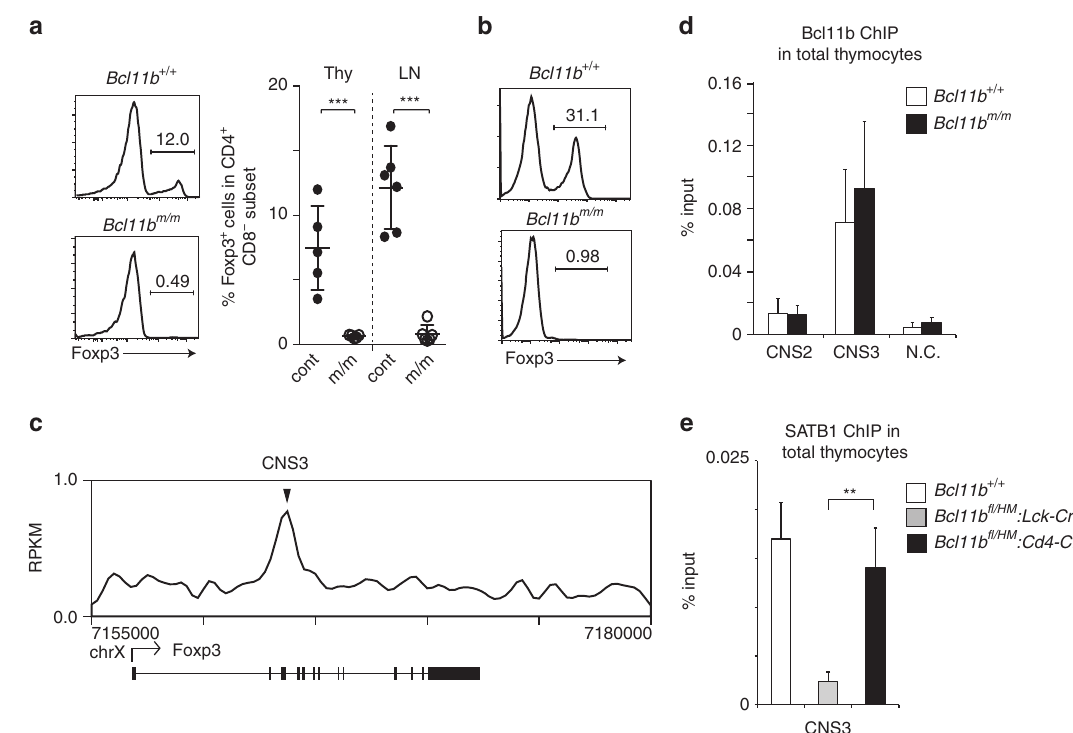
Fig. 7 Regulation of Foxp3 expression by Bcl11b. a Expression of Foxp3 in CD4 + CD8 − mature thymocytes differentiated in Rag1-KO hosts from Bcl11b + / + and Bcl11b m/m fetal liver progenitors. A representative histogram ( left ) along with a summary of fi ve independent hosts ( right ) are shown. *** P < 0.001 (unpaired t -test). b Histogram showing Foxp3 induction from CD62L + CD4 + T cells after in vitro culture under Treg differentiation condition. One representative of two experiments. c Bcl11b ChIP-seq tracks at the Foxp3 gene in DP thymocytes. Gene structure, transcriptional orientation and position of conserved non-coding sequence (CNS) 3 are indicated. d Summary of ChIP-qPCR assay for binding of Wt (white bars) and hypomorphic (black bars) Bcl11b to CNS2 and CNS3 regions in the Foxp3 locus in neonatal total thymocytes. e ChIP-qPCR for binding of SATB1 to the CNS3 enhancer in the Foxp3 gene. Chromatin was collected from DP thymocyte precursors using mice with the indicated genotypes. Combined data from three independent ChIP experiments are shown. ** P < 0.01 (unpaired t